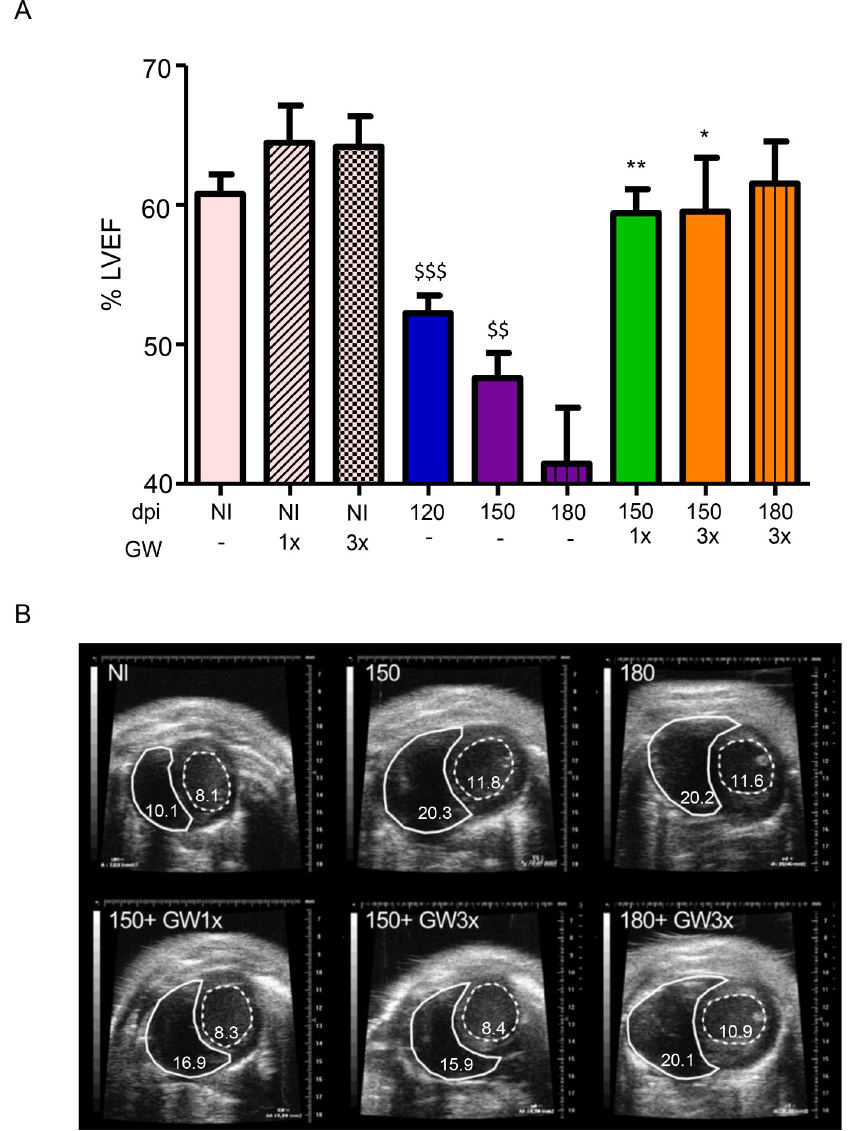
Fig 5. GW788388 treatment reverses heart-contraction in mice chronically infected with T . cruzi . Mice were infected with T . cruzi from the Colombian strain (10 2 parasites). Treatment with GW788388 started on 120 dpi until 150 dpi administered once (GW1x) and thrice (GW3x) a week, followed up until 180 dpi. Echocardiography analysis showing (A) left ventricle ejection fraction (% LVEF); (B) right (continuous lines) and left ventricle (dashed lines) representative figure from each group of mice. Data represent mean ± standard deviation of at least 4 mice per group. Significant differences between infected and non-infected groups are indicated by $$ P < 0.01 and $$$ P < 0.001 and differences between infected mice GW788388 treated or not are indicated by � P < 0.05 and �� P < 0.01. n = 2–6 mice per